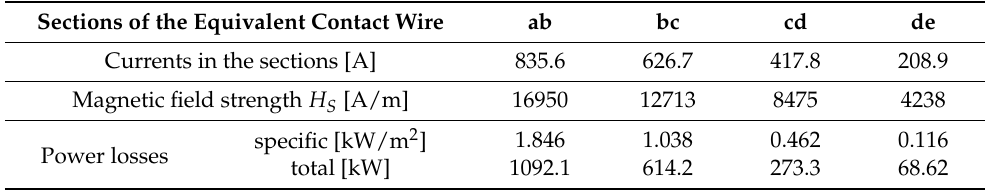
Table 2. Power losses in the equivalent contact wire.